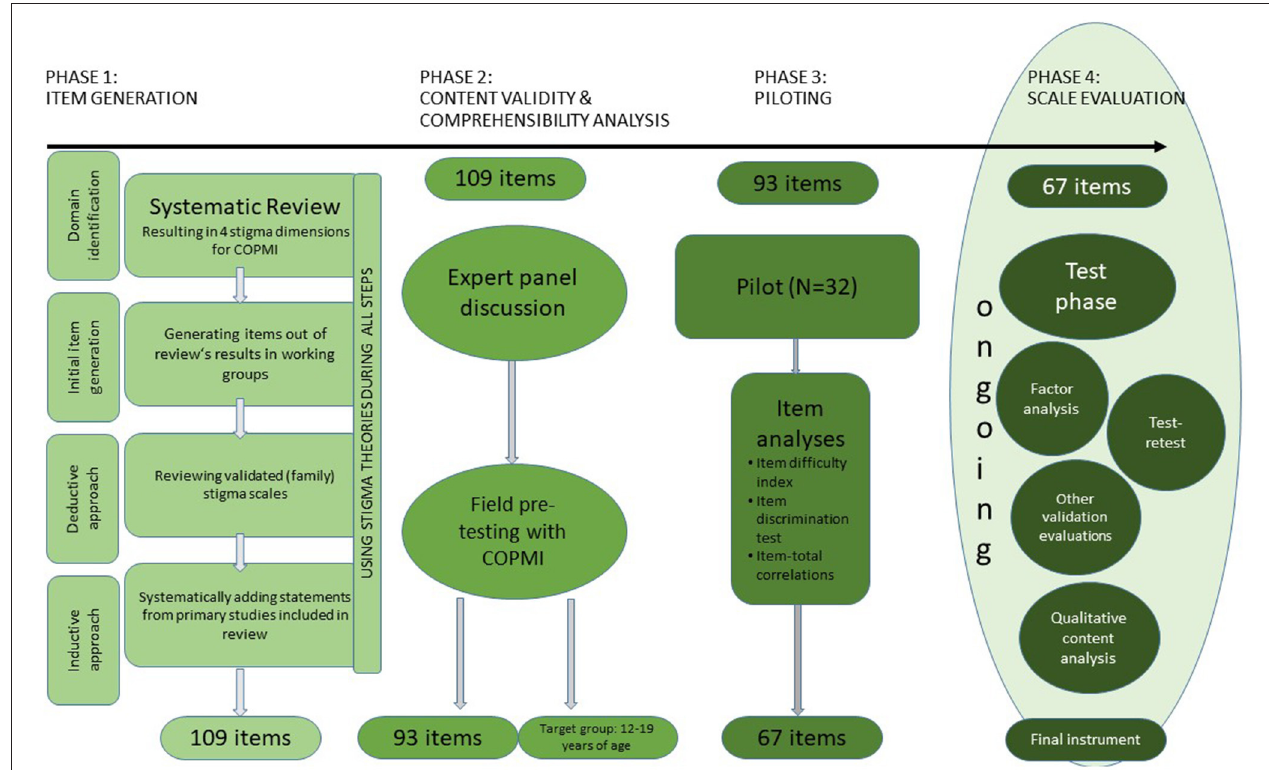
FIGURE 1 | Phases of development of the instrument measuring stigma in COPMI (COPMI-SQ).